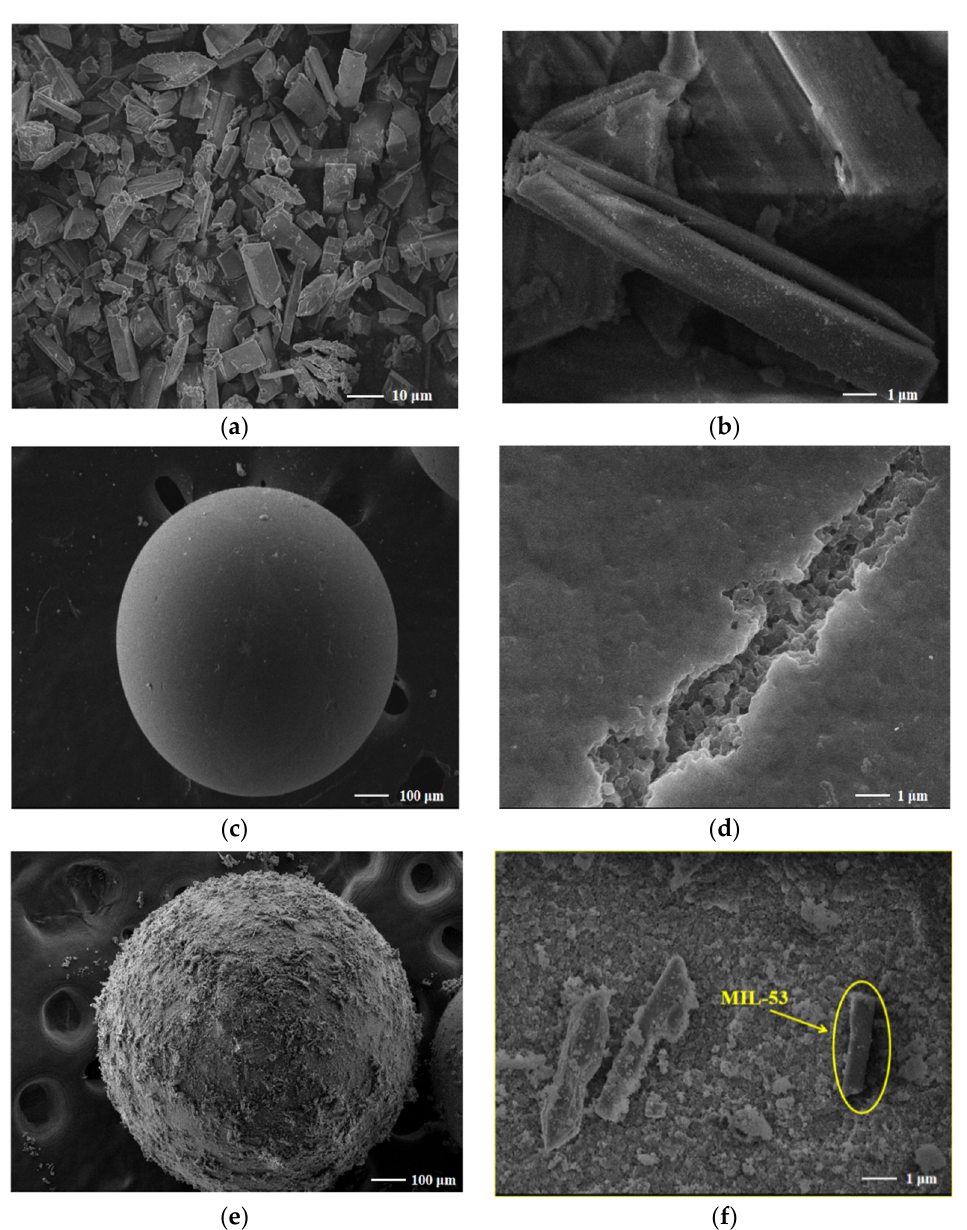
Figure 4. SEM image of MIL-53 ( a , b ), D201 ( c , d ), MIL-53/D201 composite ( e ), and MIL-53/D201 composite transverse section ( f ) at different magnifications.